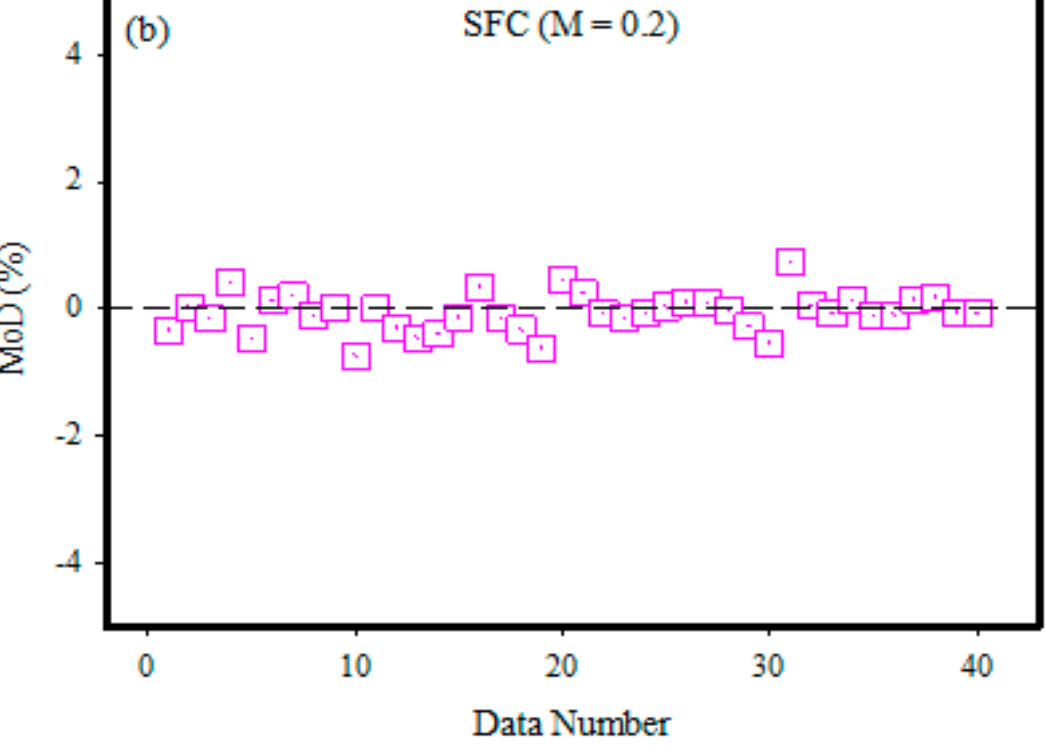
Figure 7. ( a , b ). MoD values for each data point for M = 0 and M = 0.2.